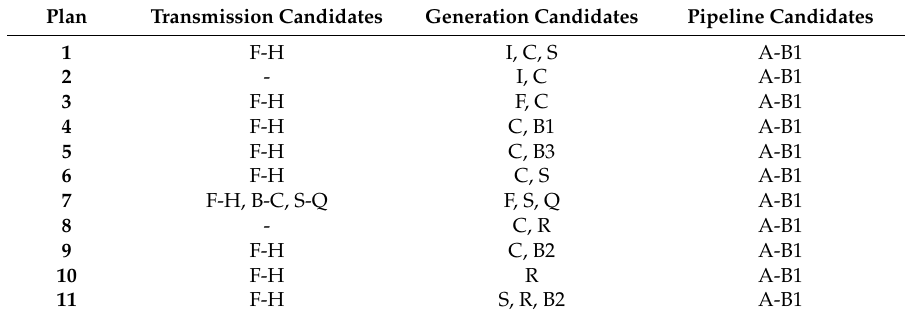
Table 4. Alternatives considered for expansion planning of gas and electricity networks considering restriction in investment